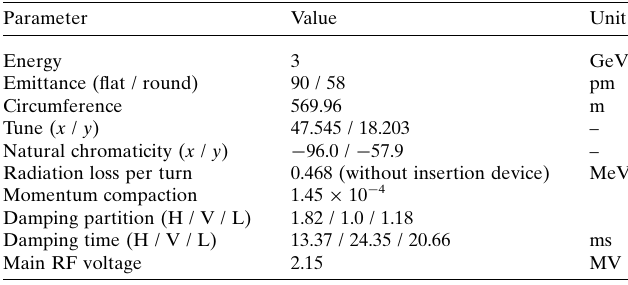
Table 1 Parameters relevant to the PAL-4GSR lattice.